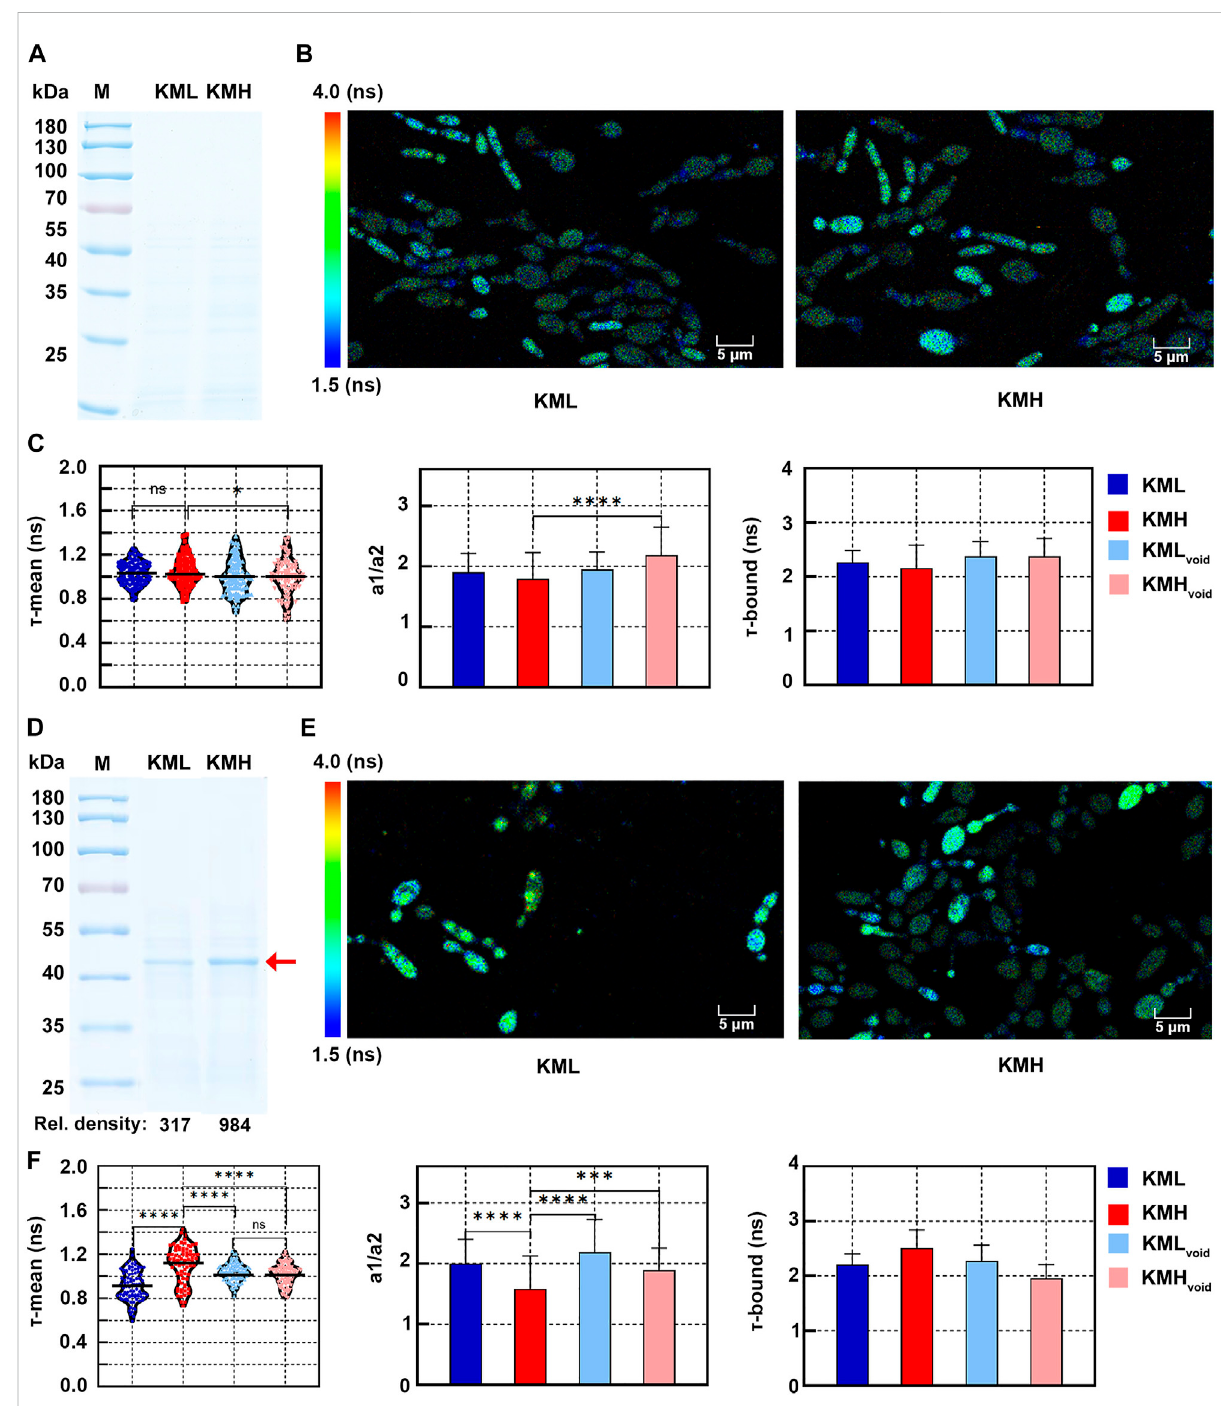
FIGURE 3 Redox states of K. marxianus cells displaying different expression levels of a heterologous protein. (A) SDS-PAGE of supernatant of KML and KMH culture after 1 day of growth. (B) FLIM of NAD(P)H in KML and KMH cells after 1 day of growth. Pseudocolor mapping of NAD(P)H fl uorescence lifetimeswasshown. Thelifetimefrom1.5to4.0 nswasassigneddifferentcolors. (C) QuantitativeanalysisofNAD(P)H fl uorescencelifetimesofcells after 1 day of growth. A violin plot showed the distribution of τ -mean of cells and the mean value was indicated by a black line. Histograms showeda1/a2and τ -bound,inwhichvaluesrepresentedmean±SD.Atotalof94KML,105KMH,104KML void and78KMH void cellswerecounted. “ ns ” indicated p > 0.05.* p < 0.05;**** p < 0.0001. (D) SDS-PAGEofsupernatantofKMLandKMHcultureafter3 daysofgrowth.ThepositionofIBDV-VP2 was indicated by a red arrow and the relative densities of bands were shown below. (E) Pseudocolor mapping of NAD(P)H fl uorescence lifetimes of KMLand KMHcellsafter3 daysofgrowth. (F) Quantitativeanalysis ofNAD(P)H fl uorescencelifetimesofcellsafter 1 dayofgrowth.Atotalof91KML, 79 KMH, 96 KML void and 102 KML void cells were counted. *** p <